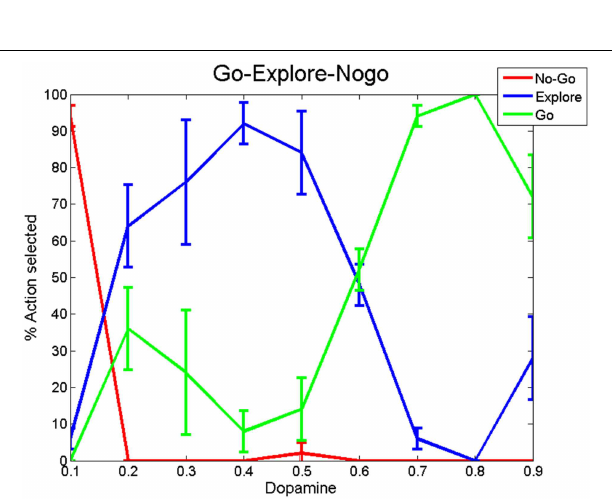
FIGURE 12 | Model Activity at high DA ( = 0.9) state where x-axis represents the time of spiking and y-axis is the spatial representation of 2500 neurons. S1 and S2 represent the 2 stimuli which were given spatially to the network.